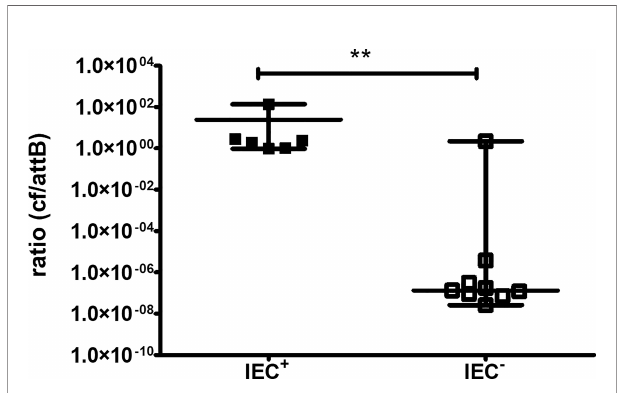
FIGURE 4 | RT-qPCR for the circular form of the bacteriophage and the phage-free chromosomal integration site ( attB ). The circular form (cf) of the bacteriophage and phage-free chromosomal site ( attB ) were detected by PCR. Isolates are regarded as IEC + and IEC - according to WGS data. Results of three independent experiments performed as duplicates. The comparison of two data groups were analyzed by Mann – Whitney U test (one-tailed, con fi dence intervals 95%) with **P < 0.01.